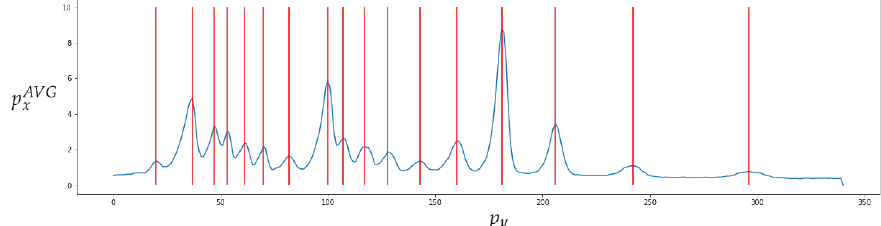
Figure 18. Recognition of peaks in the average curve obtained from the bottom image in Figure